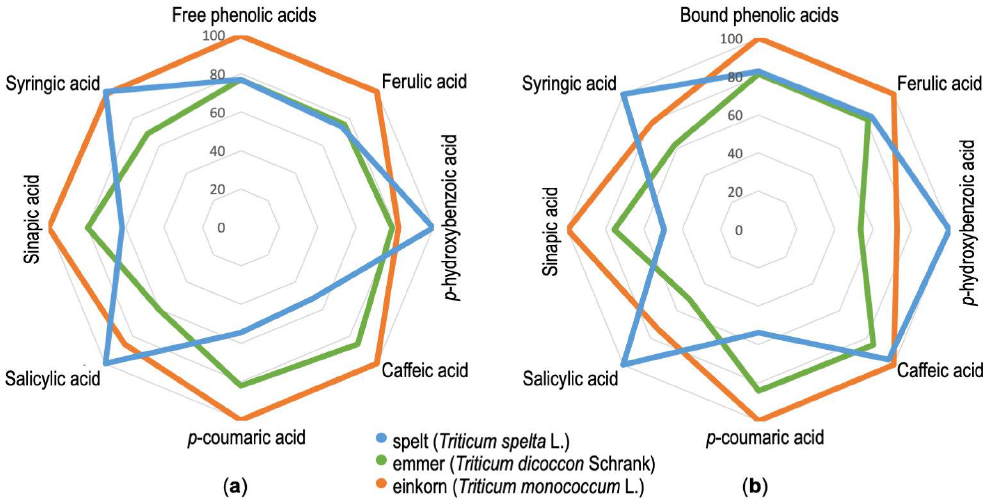
Figure 1. Percentage difference in concentration of free ( a ) and bound ( b ) phenolic acids in whole grain flour from three hulled ancient wheat species.